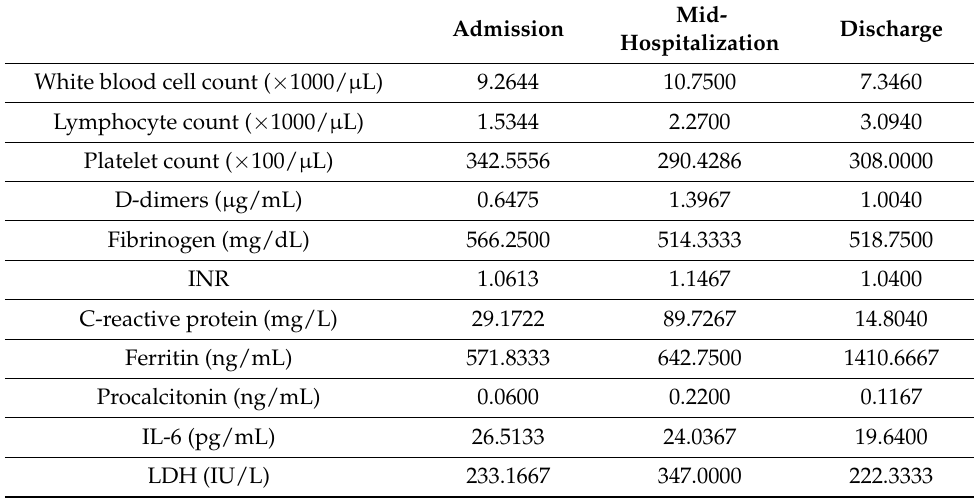
Table 2. Mean blood test